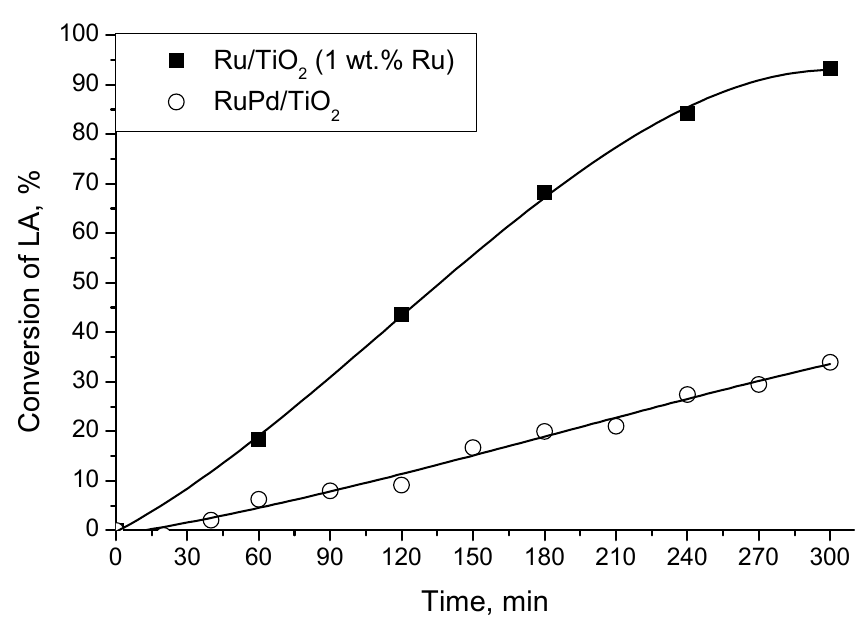
Figure 5. LA conversion versus time for the bimetallic RuPd/TiO 2 catalyst. Reaction conditions: 90 °C, 45 bar H 2 , C LA,0 = 0.6–0.7 mol/L, m cat = 0.06 g, stirring rate = 2000